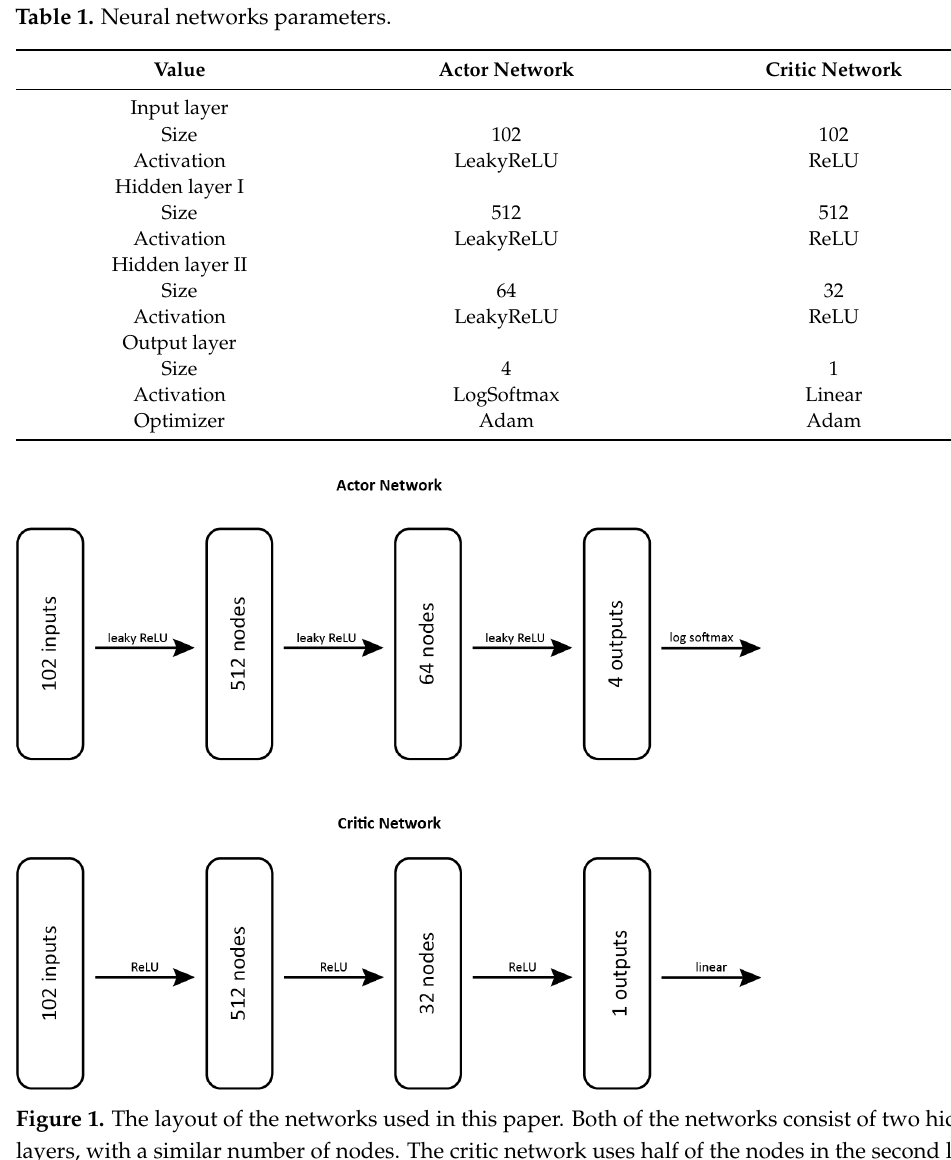
Table 1. Neural networks parameters.